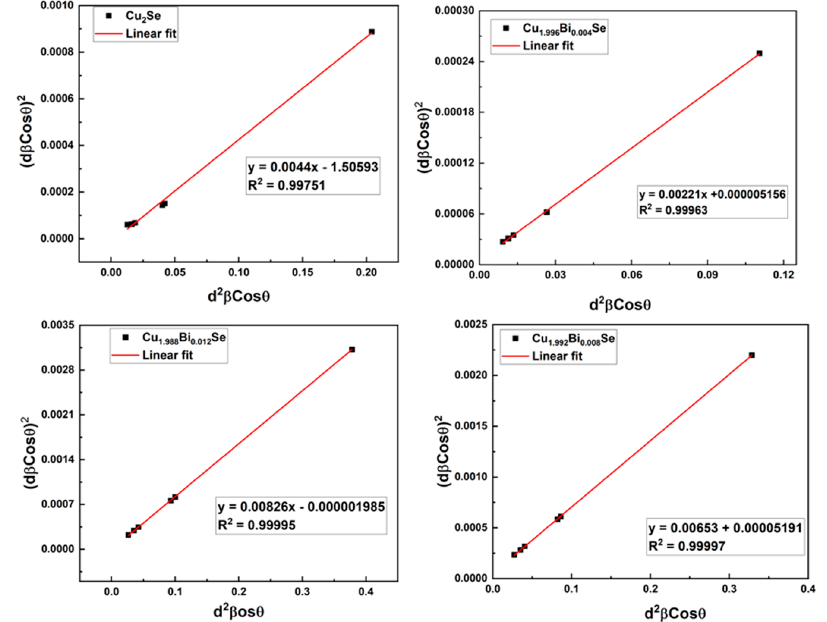
Figure 4. Size-Strain plots of Cu 2 − x Bi x Se samples.